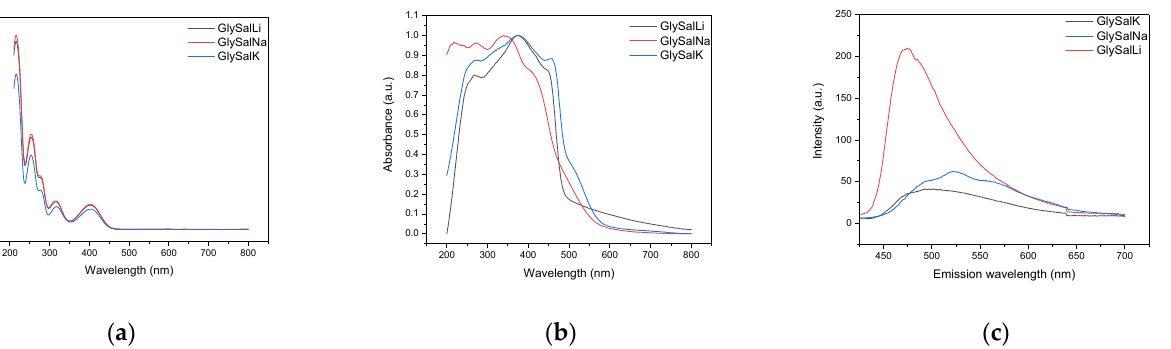
Figure 4. Optical absorption spectra of GlySalX in ( a ) methanol; and ( b ) solid form. ( c ) Corresponding emission in solid form.